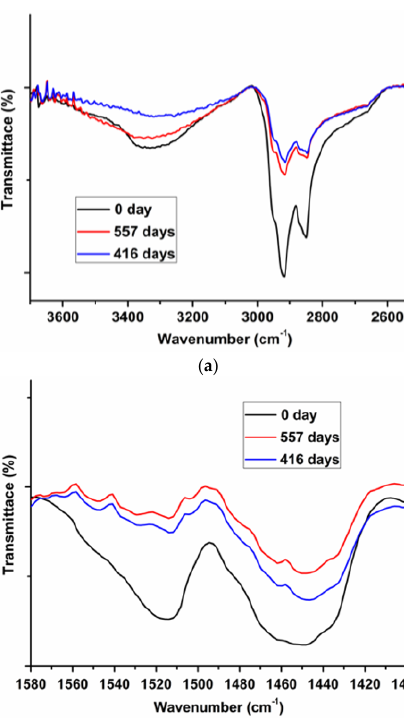
Figure 4. Windows of FTIR-ATR spectra of mirror A1 paint samples before and after exposure at the desert site. ( a ) 3500– 2500 cm −1 ; ( b ) 1800–1500 cm −1 ; ( c ) 1580–1400 cm −1 ; ( d ) 1400–1050 cm −1 . Many changes were observed on Mirror type A1 after exposure at both sites. Con- cerning mirrors C2 and D2, no significant differences were detected between samples an- alyzed before and after exposure, except the absorption bands at 3650–3100 cm −1 and 2926–2855 cm −1 . Table 7 lists the main functional groups and pigments of paint samples.